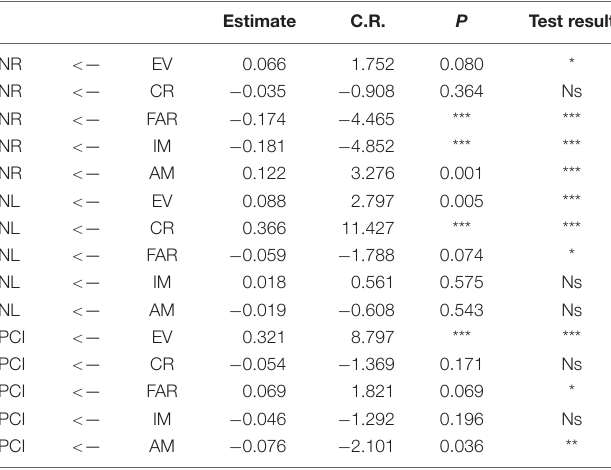
TABLE 8 | Significance test of model path